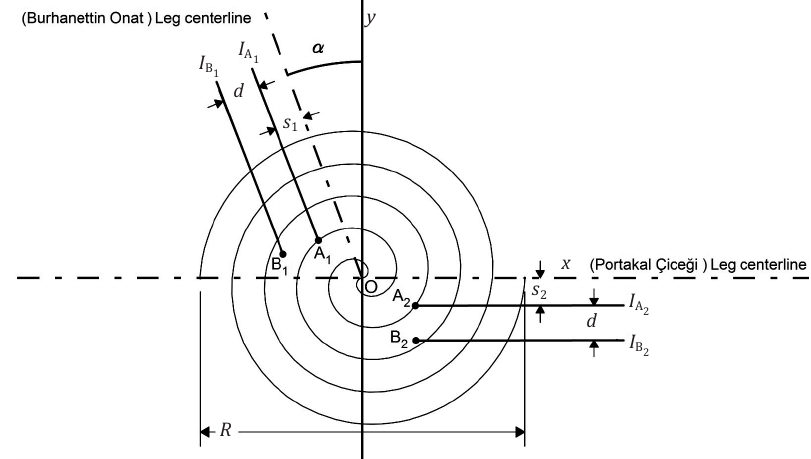
Figure 7a. Placing the proposed roundabout design into Cartesian coordinate system (by Y. User)